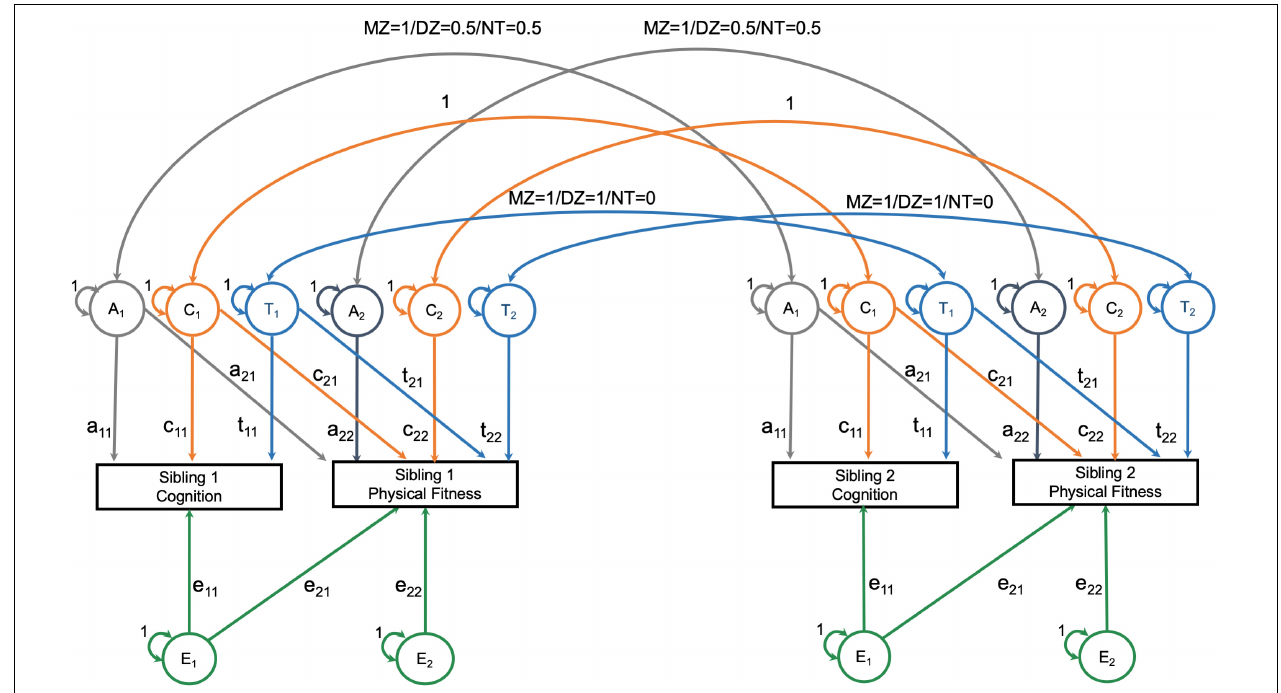
FIGURE 1 | Overview of bivariate Cholesky decomposition